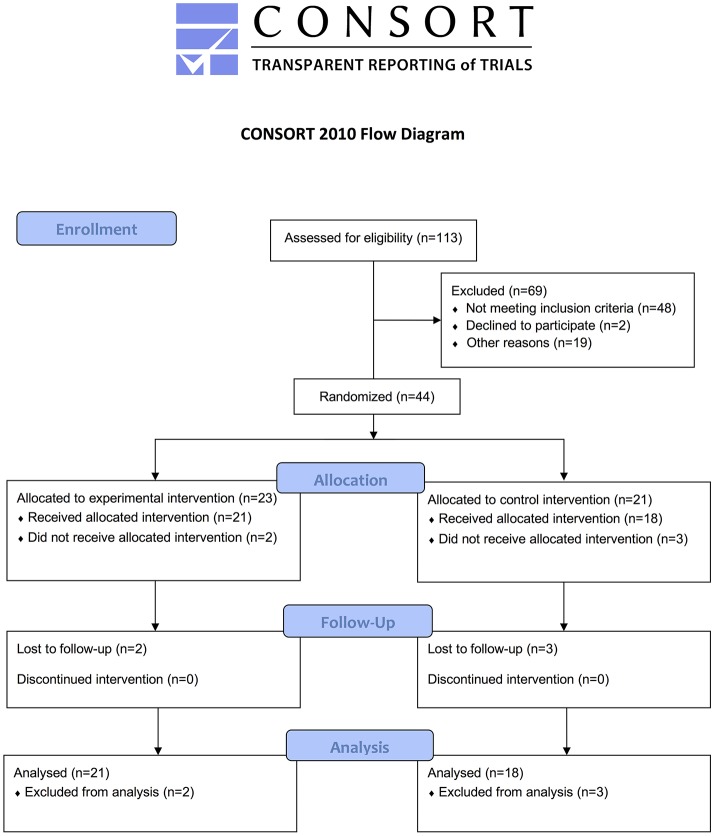
CONSORT flowchart.